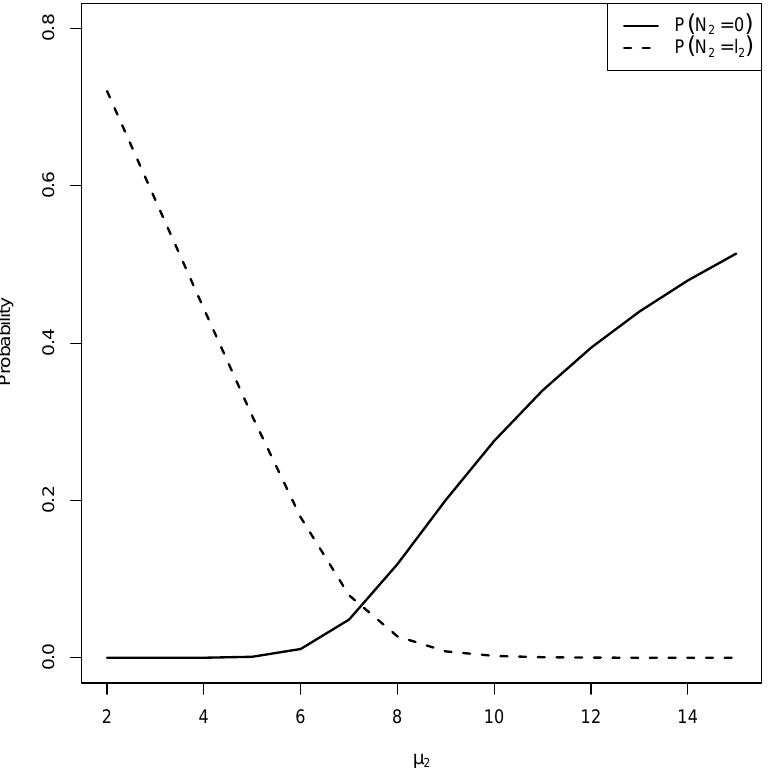
Figure 3. Dependency of the probabilities of an empty (full) class 2 queue on µ 2 ∈ [ 2,15 ] , fixed γ = 10, s = 7, S = 100, l 2 = 15, µ 1 = 7, MMAP arrival process parameters given in